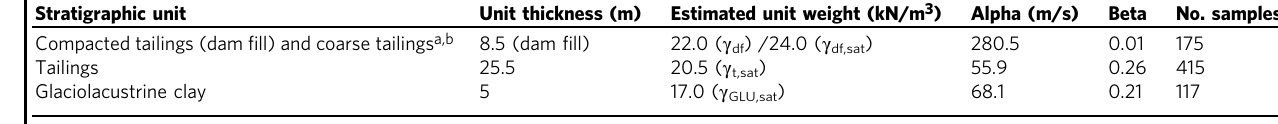
Table 1 Model parameters and site-speci fi c alpha and beta parameters obtained from regression with bootstrap analyses. Stratigraphic